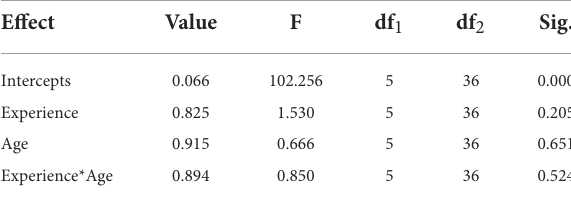
TABLE 4 Multivariate results for coaches on the contribution of age and years of experience on organizational stressors.